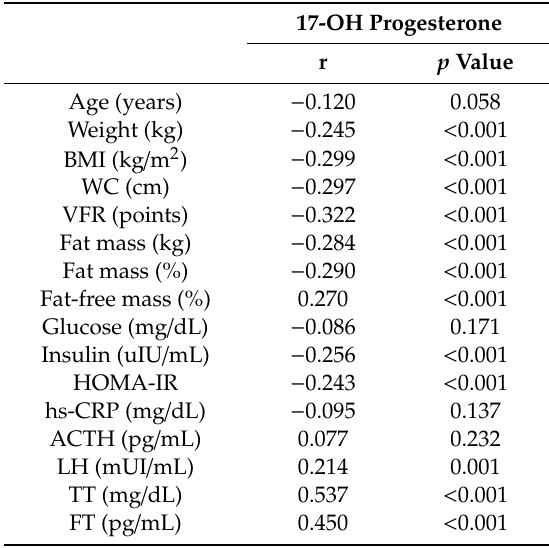
Table 3. Correlation coe ffi cients among 17-OH progesterone and anthropometric, biochemical, and hormonal parameters.